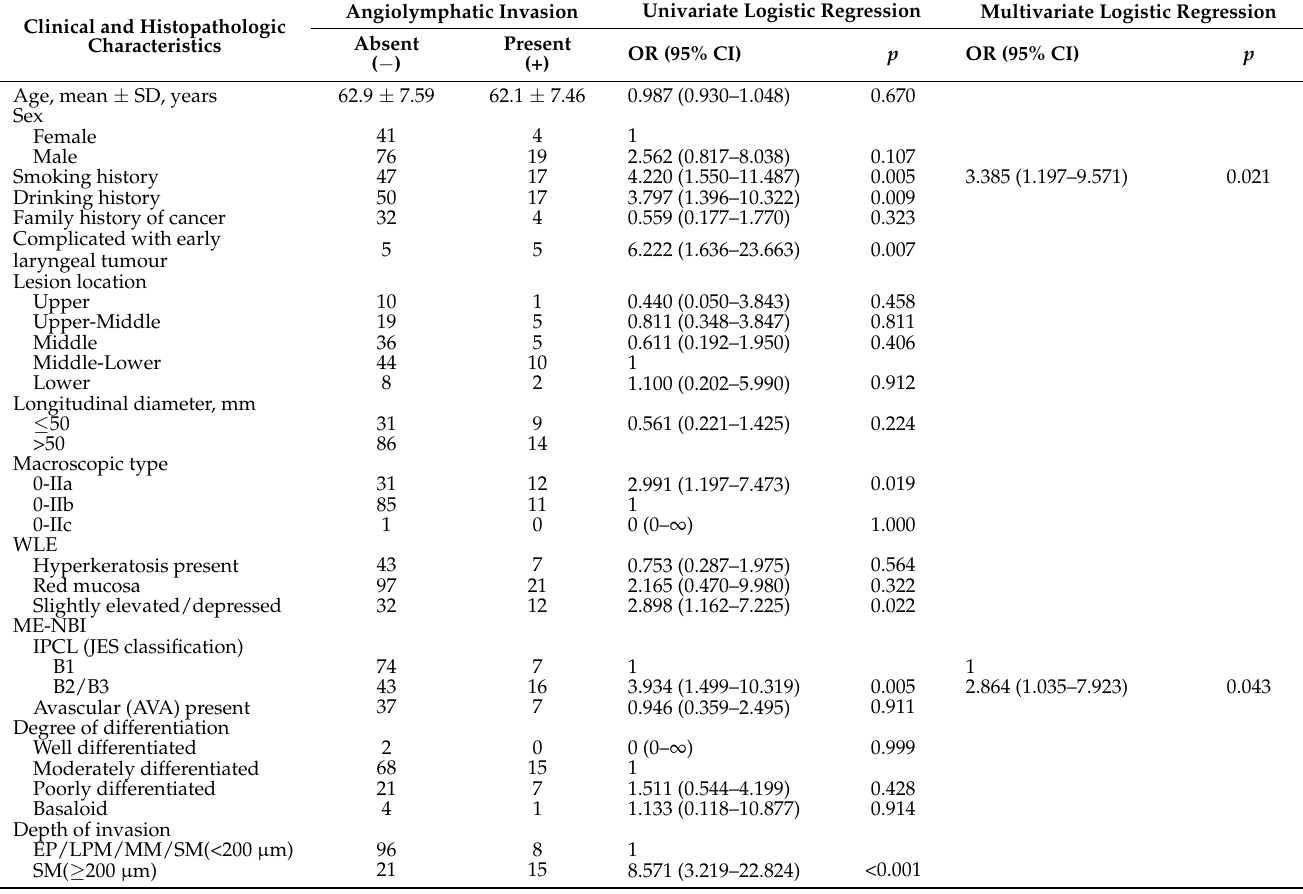
Table 2. Univariate and multivariate logistic regression analysis for angiolymphatic